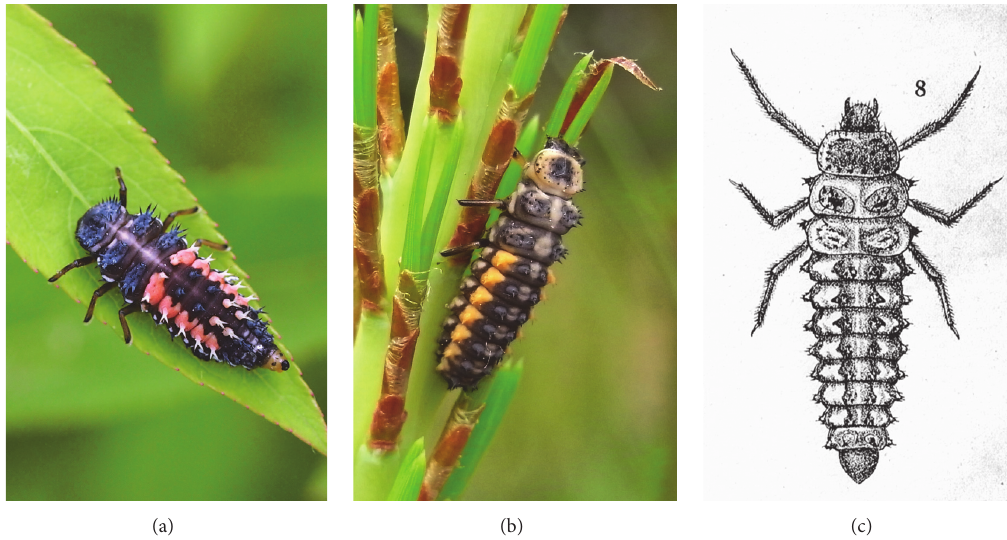
Figure 2: (a) A final instar larva of H. axyridis on a Spiraea thunbergii leaf. (b) A final instar larva of H. yedoensis on Japanese red pine, Pinus densiflora . (c) Illustration of a final instar larva of H. yedoensis by Kurisaki [23].